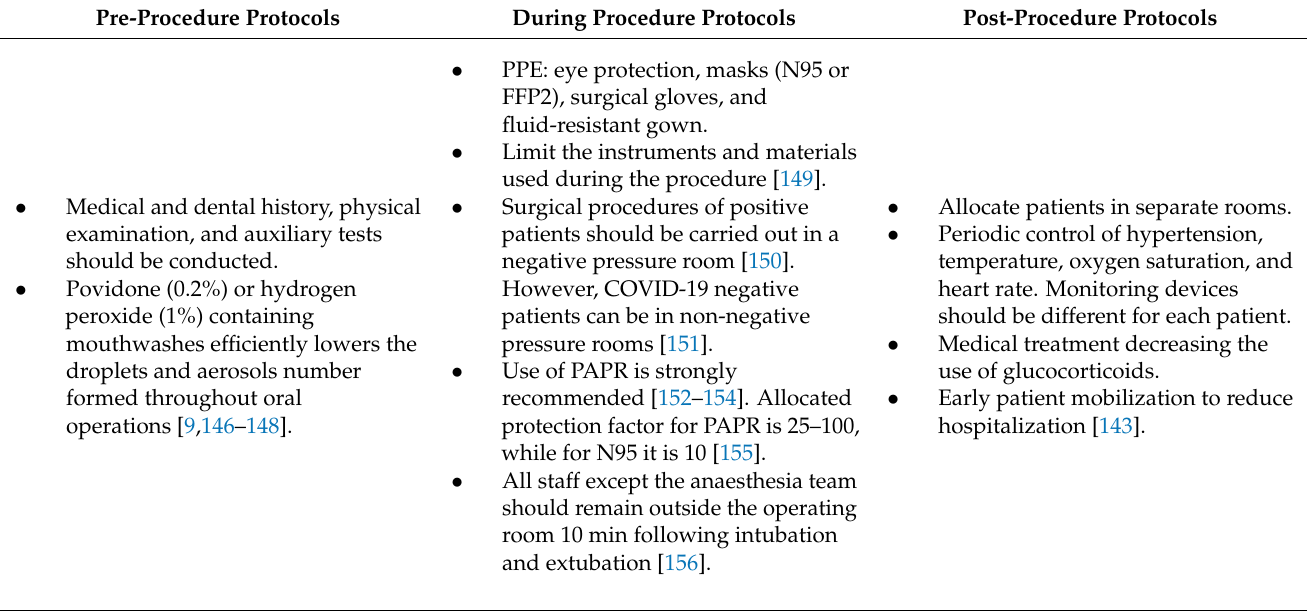
Table 10. Protocols for maxillofacial procedures during COVID-19